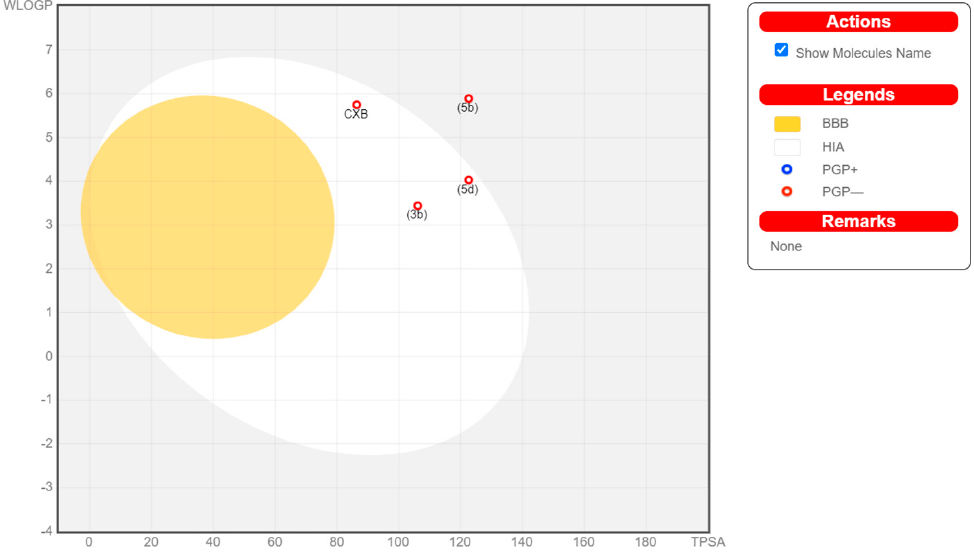
Figure 8. Boiled-Egg chart of investigated compounds 3b , 5b , 5d , and Celecoxib. Table 6. The in silico predicted pharmacokinetics for compounds 3b , 5b , and 5d , as well as Celecoxib. Molecule GI